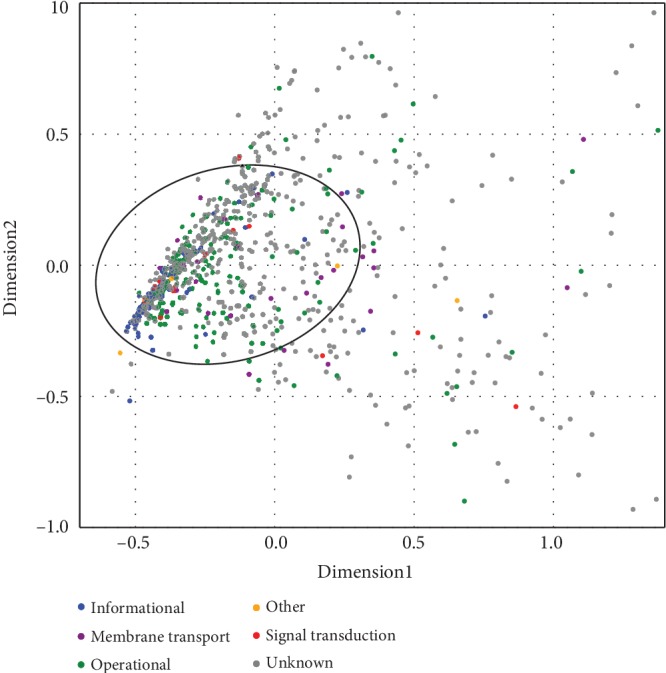
Plot of the two first axes of the PCoA made from 796 ML trees. The other 33 genes are excluded due to the limit of axis demarcation. The ellipse depicts 562 orthologs in the densest region (stable core region) of the cloud that share a common phylogenetic signal, whereas trees present in the marginal area (the shell) are much more likely to be perturbed by horizontal transfers. The genes are color-coded based on its association to biological pathways.